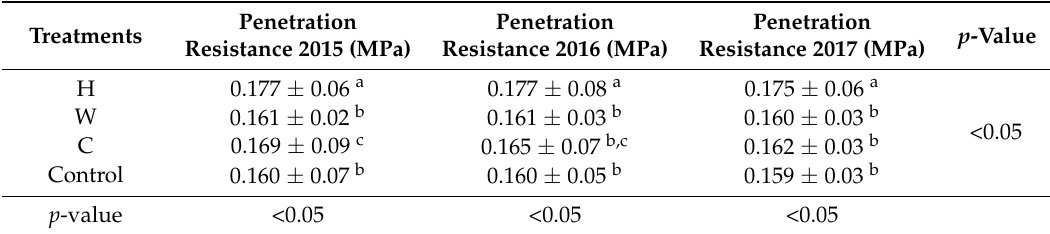
Different letters show significant differences among values in a column (Tukey test).